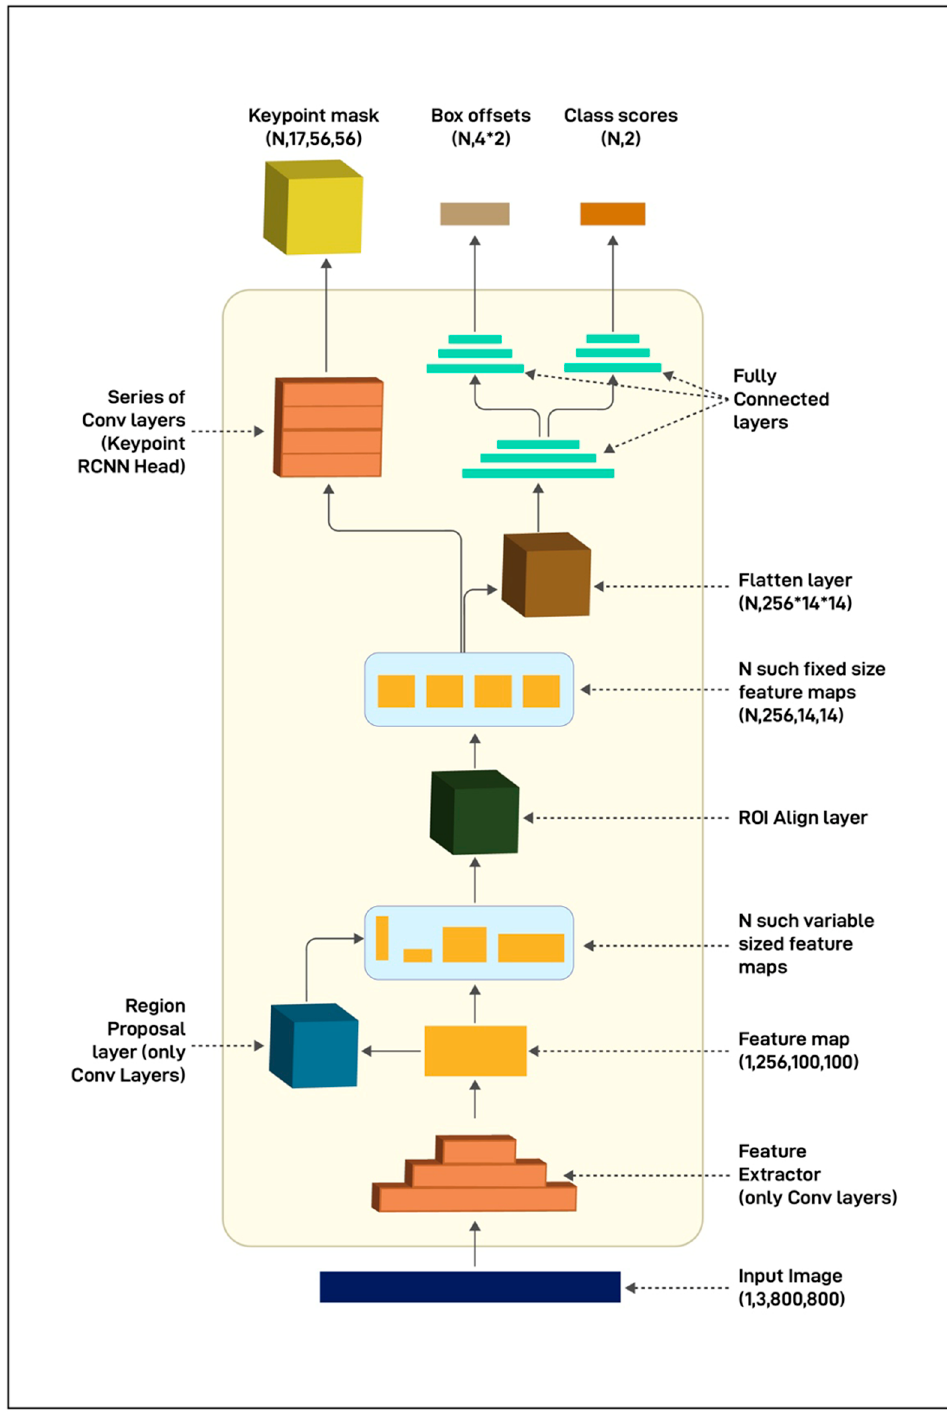
Figure 3. The architecture of keypoint R-CNN. The architecture of keypoint RCNN resembles the Mask-RCNN and only differ in the output size and the way the keypoints are encoded in the keypoint mask.